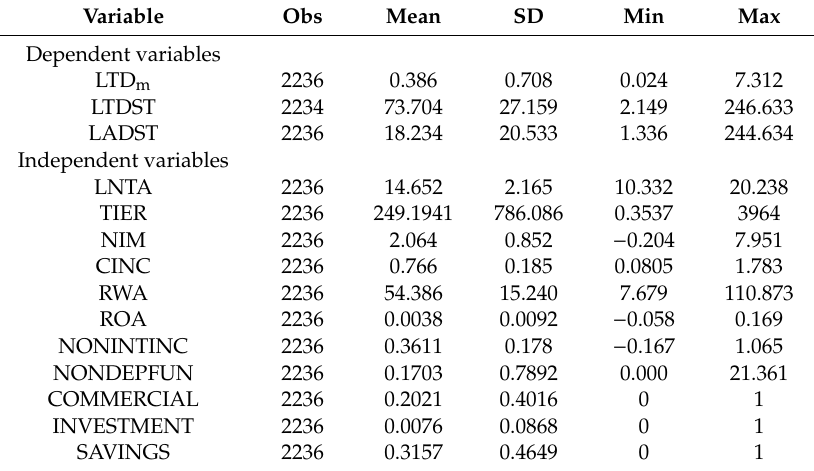
Table 1. Descriptive statistics variables.